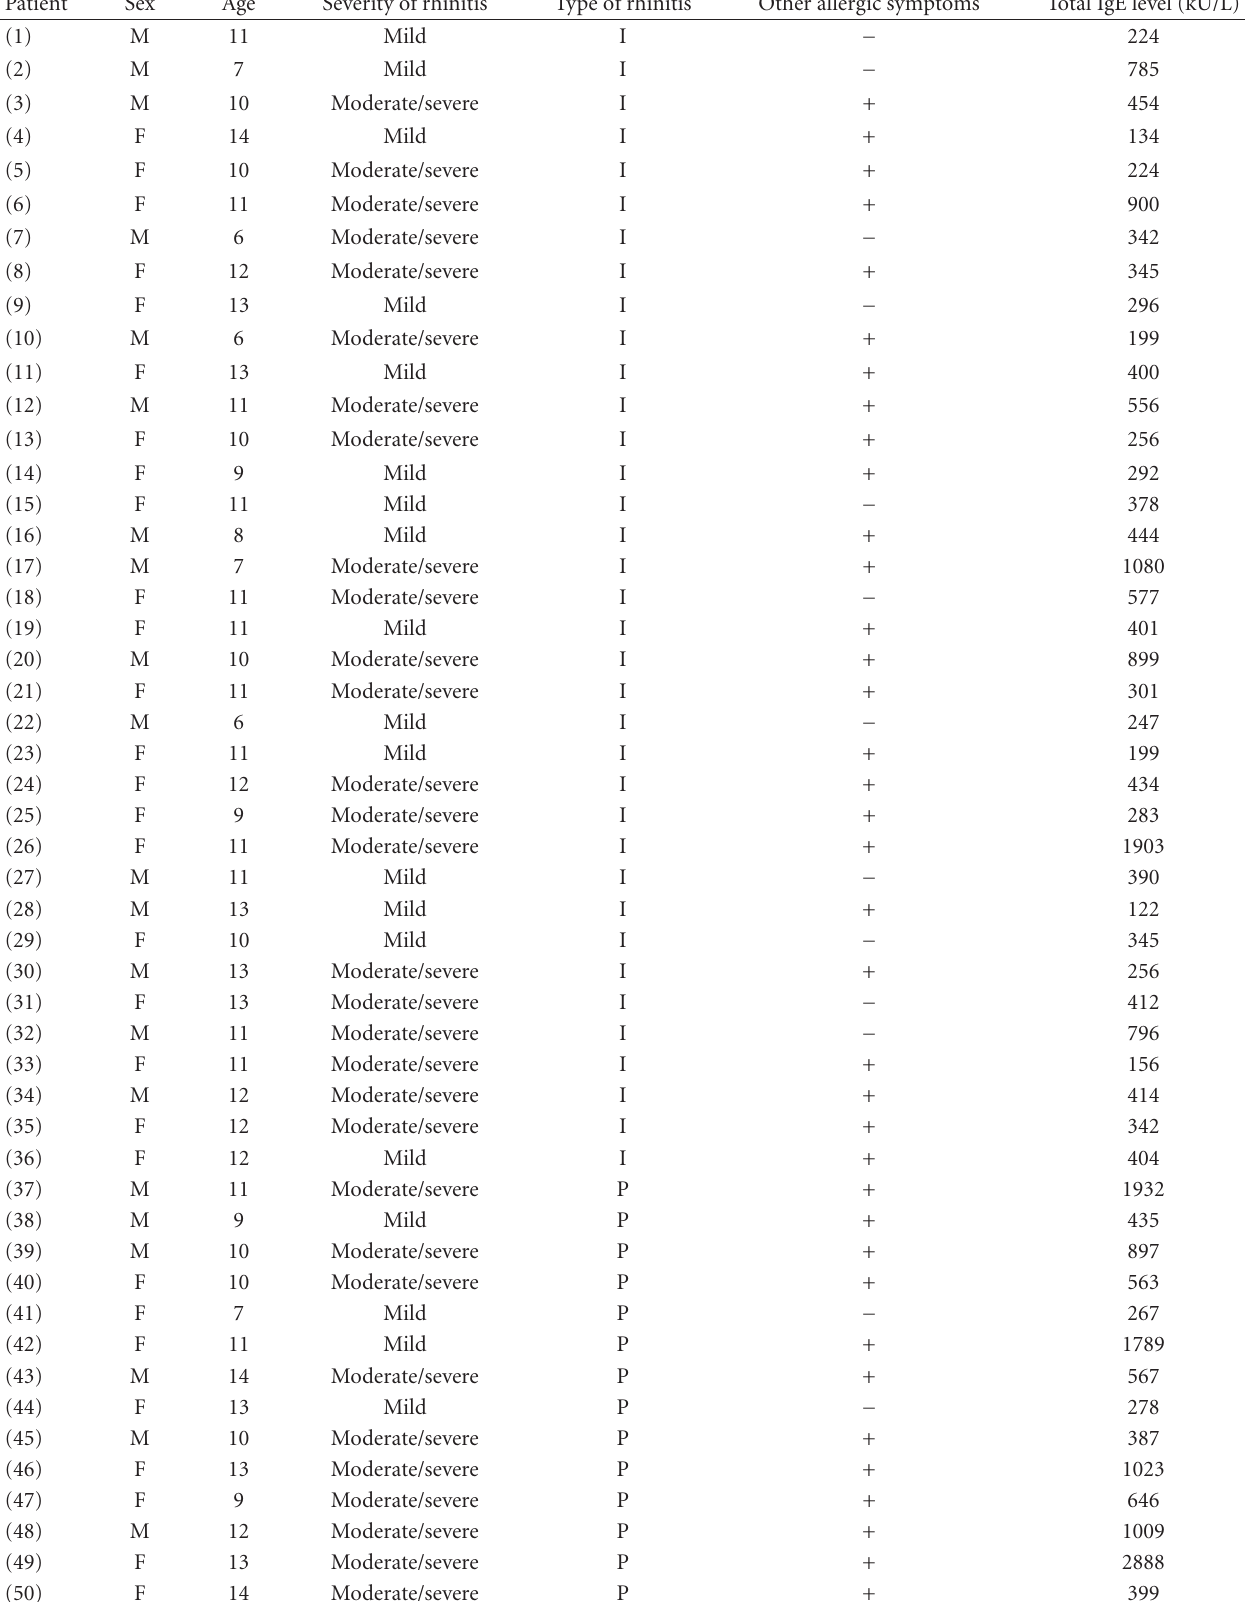
Table 1: Clinical and demographic features of our